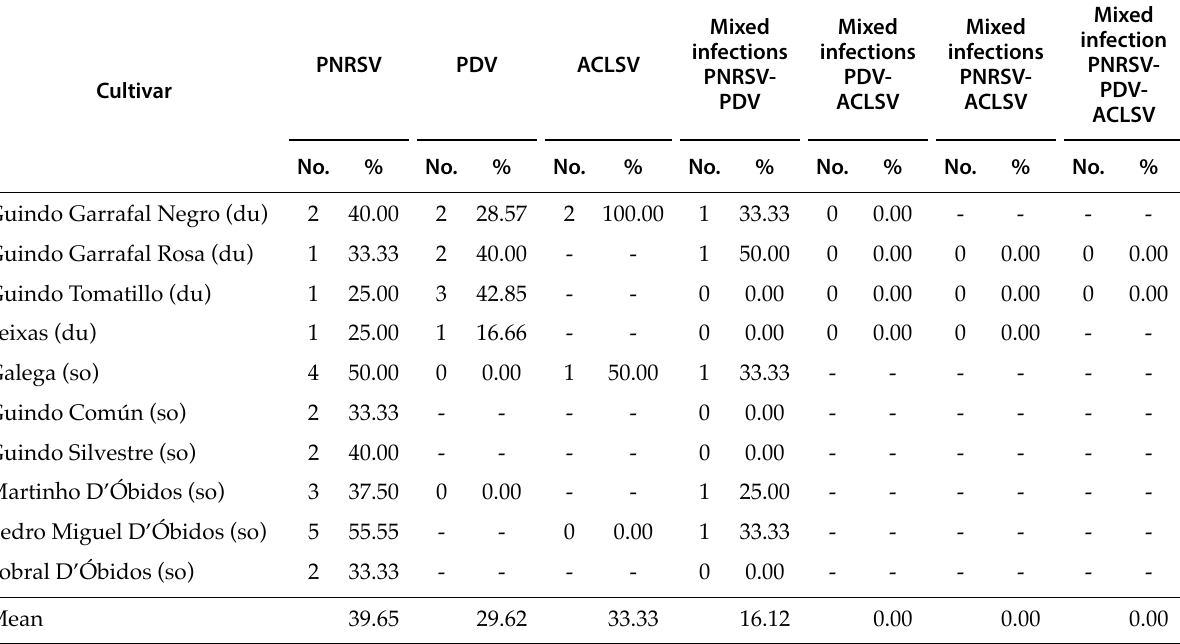
Table 3. Symptomatic trees for the PDV, PNRSV and ACLSV viruses and their mixed infections in sour (so) and duke (du) cherry cultivars from the Iberian